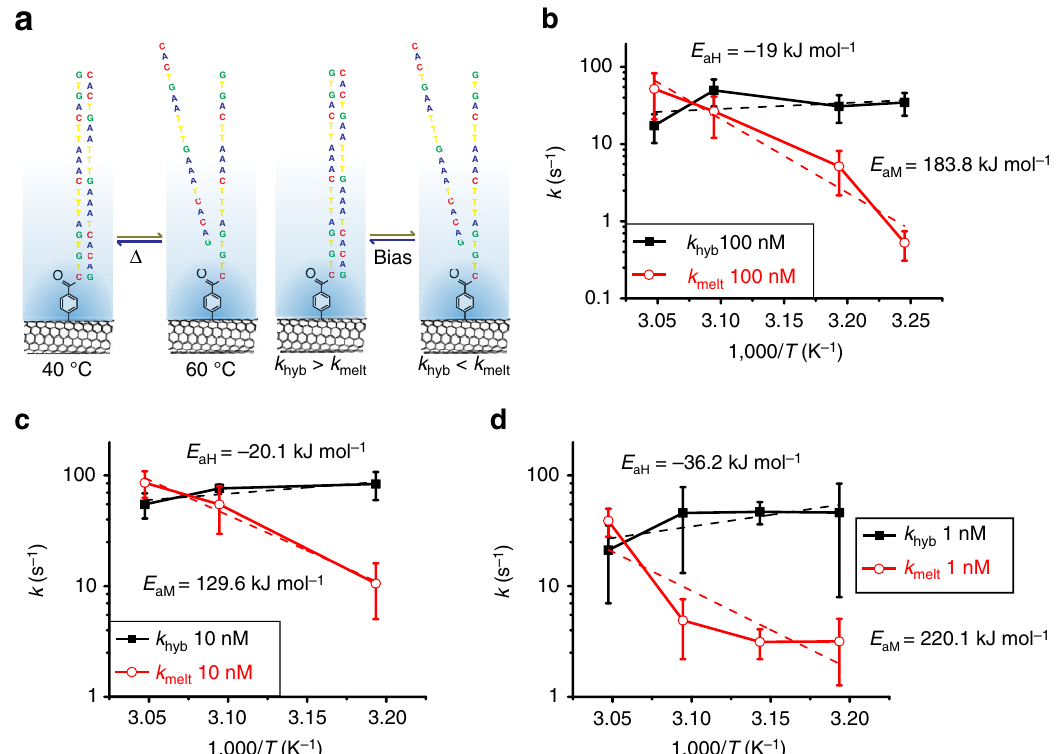
Figure 3 | The effects of bias on hybridization and melting kinetics. ( a ) Comparison of temperature and bias-dependent melting. With increasing temperature, the melting rate increases and hybridization rate decreases. Equivalently, when the gate bias increases, the equilibrium favours the melted state. ( b – d ) Arrhenius plots showing how application of gate bias affects the kinetics of melting and hybridization for 100, 10 and 1nM complementary target. Upon the application of 300mV of gate bias, the entropy of activation for the melting reactions increases, while the enthalpy of activation for the hybridization reaction decreases. Error bars are calculated from five different 60-s intervals at each temperature.